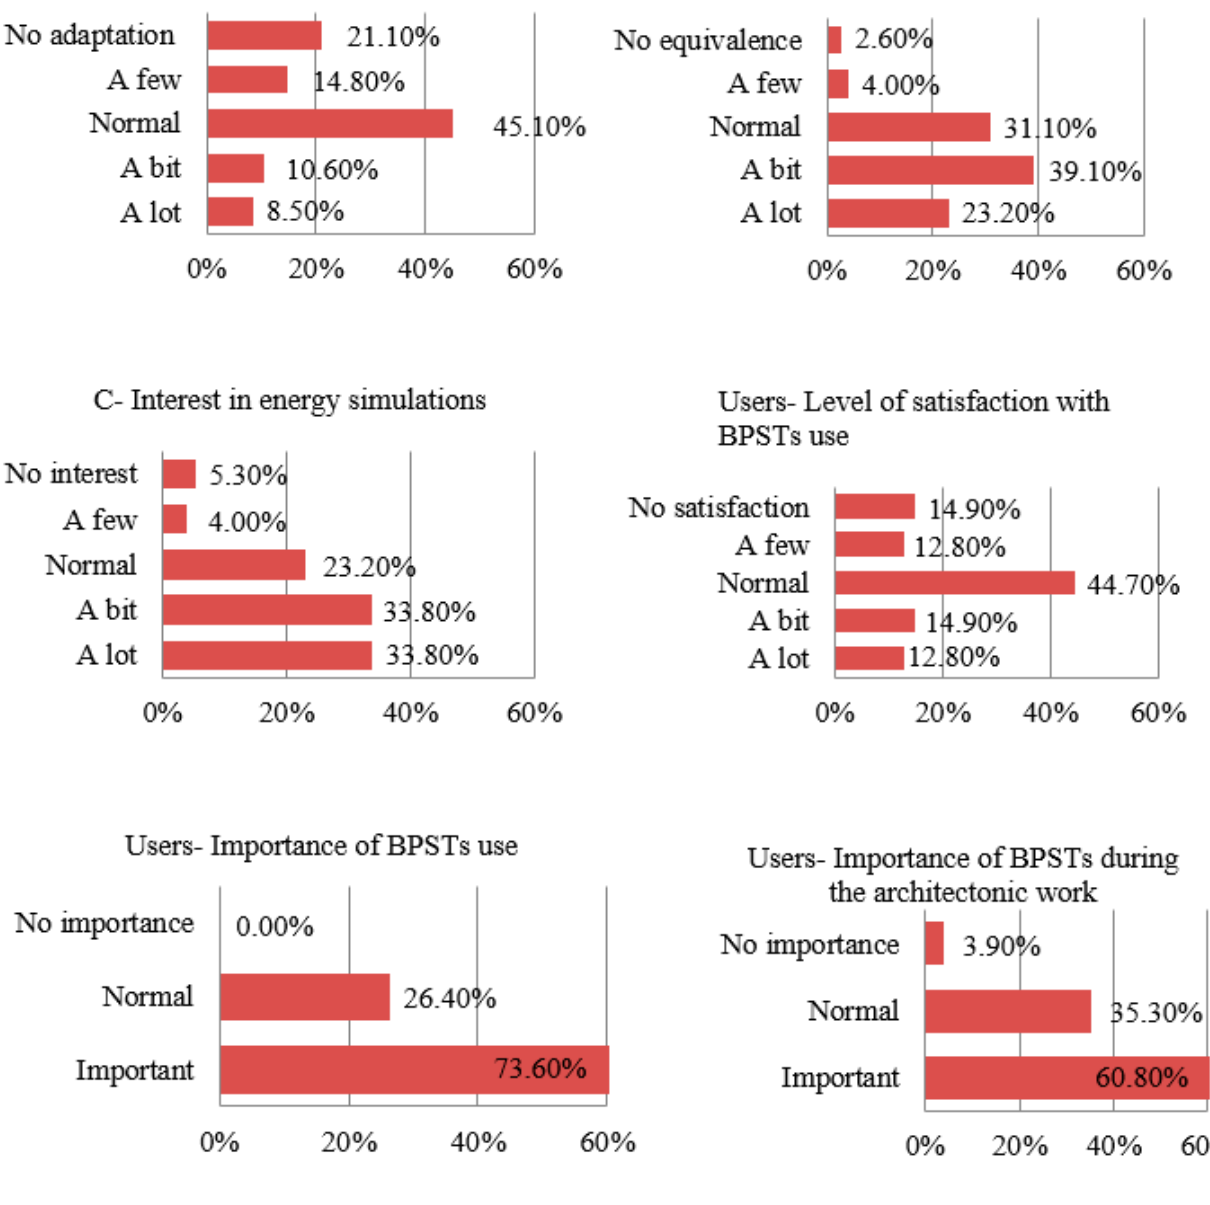
Figure 8. General opinions on the use of BPSTs.